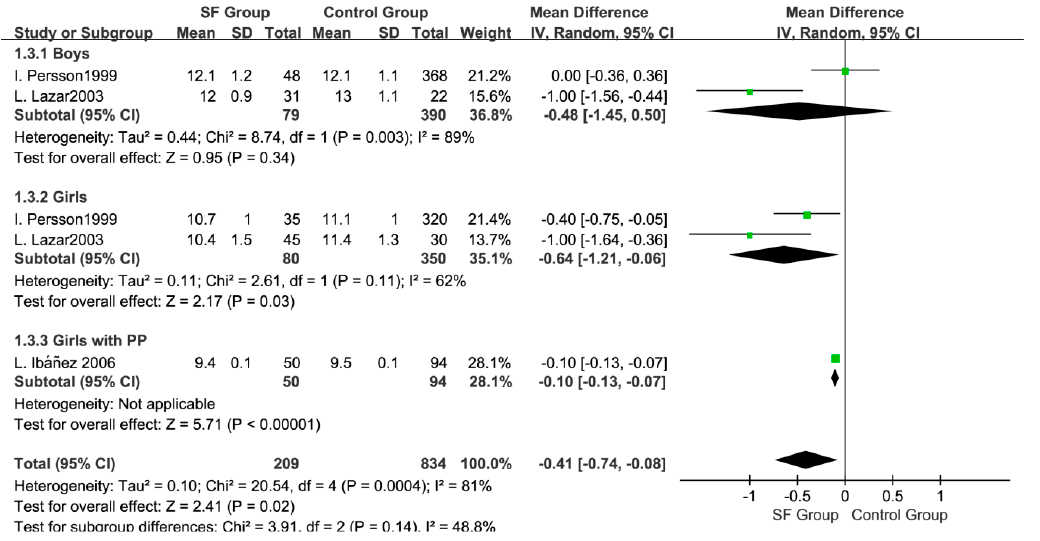
Figure 5. Forest plot for the age at onset of puberty between SF group and Control group.